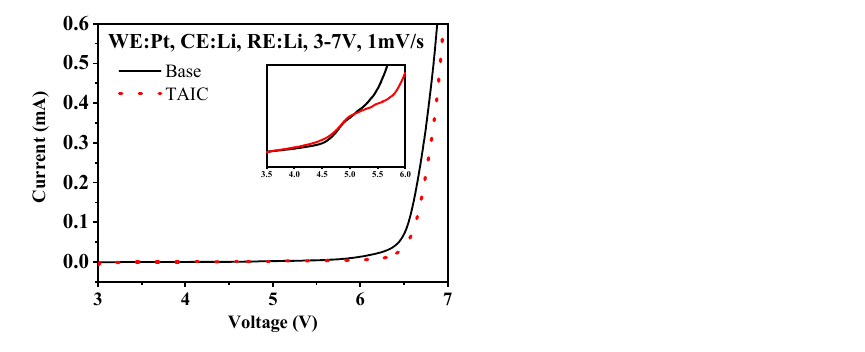
Figure 2. LSV curves of the three-electrode setup in different electrolytes (Inset: Base-1# and TAIC-2#) (The scanning voltage ranged from OCV to 7 V, and the scan rate was 1 mV/s).